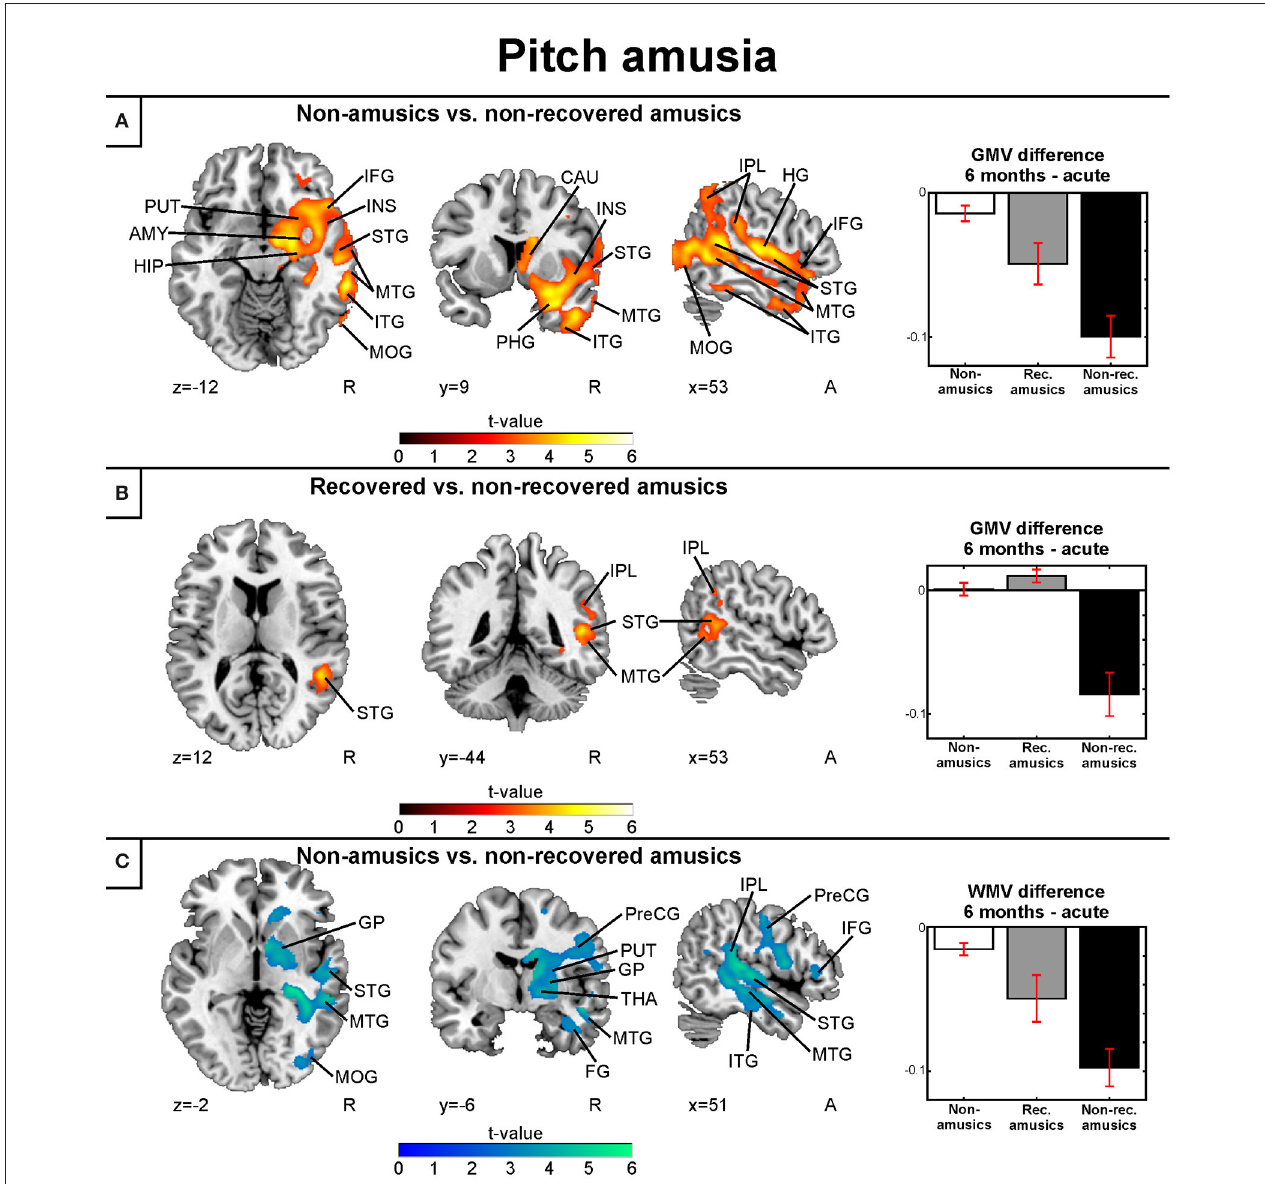
FIGURE 6 | Gray and white matter VBM results of pooled analysis: pitch amusia. Time (6 months > Acute) × Group interactions for gray matter volume. (A) Non-amusic vs. non-recovered amusics; (B) Non-amusic vs. recovered amusics, and Time (6 months > Acute) × Group interactions for white matter volume (C) Non-amusic vs. non-recovered amusics. Results are thresholded at a whole-brain uncorrected p < 0.005 at the voxel level (extent threshold: k > 100 voxels) using MNI coordinates. Only clusters surviving an FWE-corrected p < 0.05 threshold are reported and labeled (see also Tables 4, 5 ). Bar plots for GMV differences in 6 months—Acute in significant clusters ( Tables 4, 5 ) are shown: bar = mean, error-bar = standard error of the mean. AMY, amygdala; CAU, Caudate; FG, fusiform gyrus; GP, globus pallidus; HG, Heschl’s gyrus; HIP, hippocampus; IFG, inferior frontal gyrus; INS, insula; IPL, inferior parietal lobule; ITG, inferior temporal gyrus; MFG, middle frontal gyrus; MOG, middle occipital gyrus; MTG, middle temporal gyrus; PCG, postcentral gyrus; PHG, parahippocampal gyrus; PreCG, precentral gyrus; PUT, putamen; STG, superior temporal gyrus; THA,